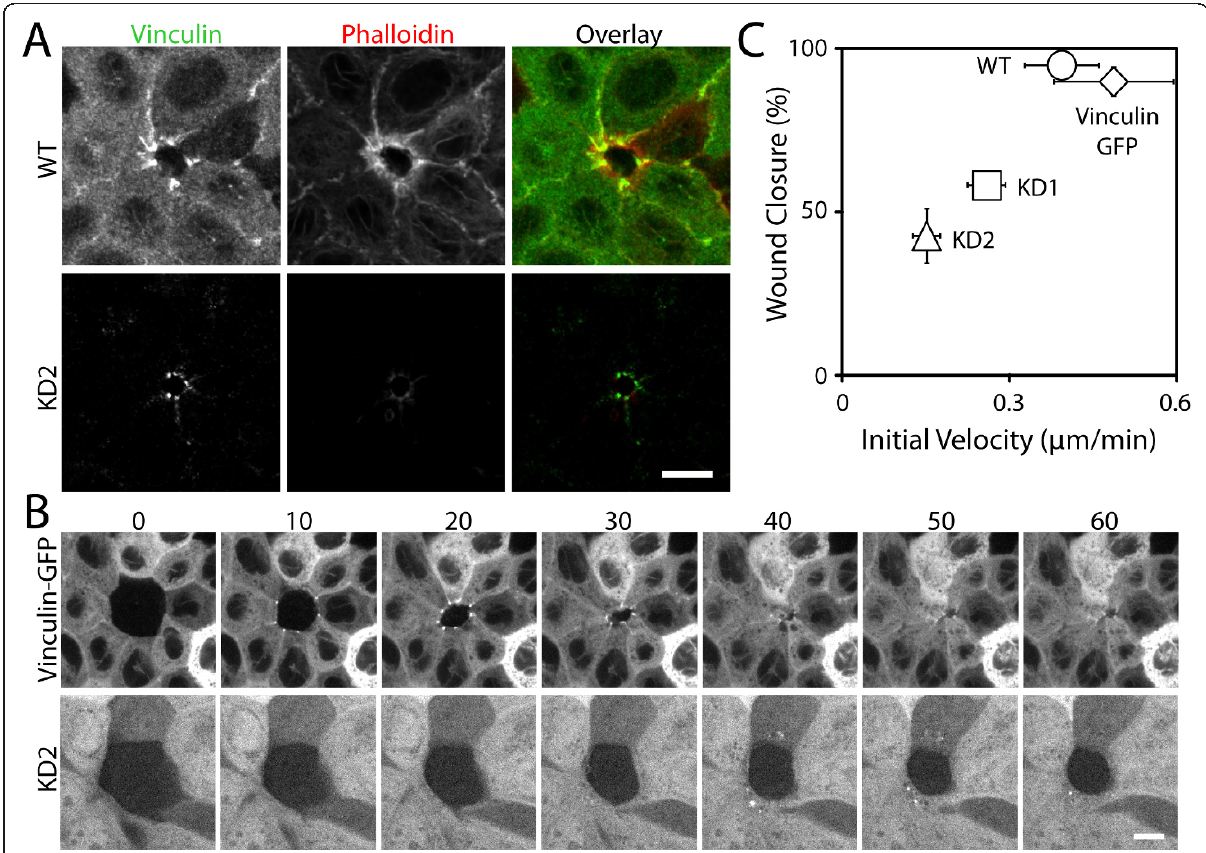
Figure 3 Vinculin knock-down decreases the rate of wound-healing in MDCK cells . (A) Following ablation of a single cell in a monolayer, an F-actin purse-string formed along the wound edge with punctate vinculin accumulation at cell-cell contacts in MDCK wild-type (WT) cells. Vinculin knock-down (KD) cells displayed decreased vinculin and F-actin accumulation along the wound edge. The same exposure and laser power were used to acquire and generate the images. Scale bar 10 μ m. (B) Time-lapse comparison of a wound-healing assay demonstrates vinculin accumulation at cell-cell contacts along the wound edge along with wound closure for vinculin-expressing (vinculin-GFP) cells and not in KD cells. Stably transfected KD cells are positive for a low level of GFP expression. Time in minutes. Scale bar 10 μ m. (C) Comparison of the percentage of wound-closure after 1 hr and the initial velocity of wound closure between WT (n = 8), vinculin-GFP (n = 9), KD1 (n = 7), and KD2 (n = 11) cells. Error bars are standard error of the